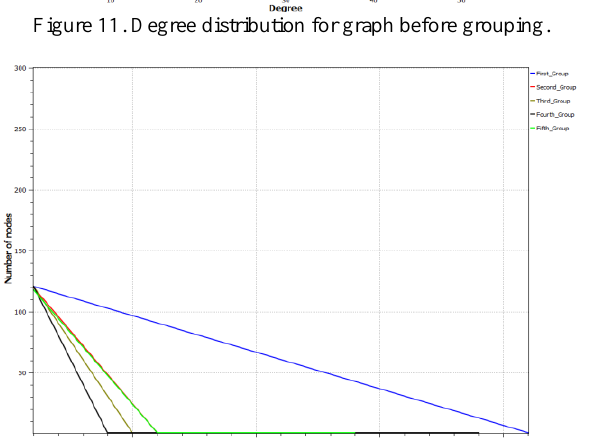
Figure 12. Degree distribution for graph after collected all groups.